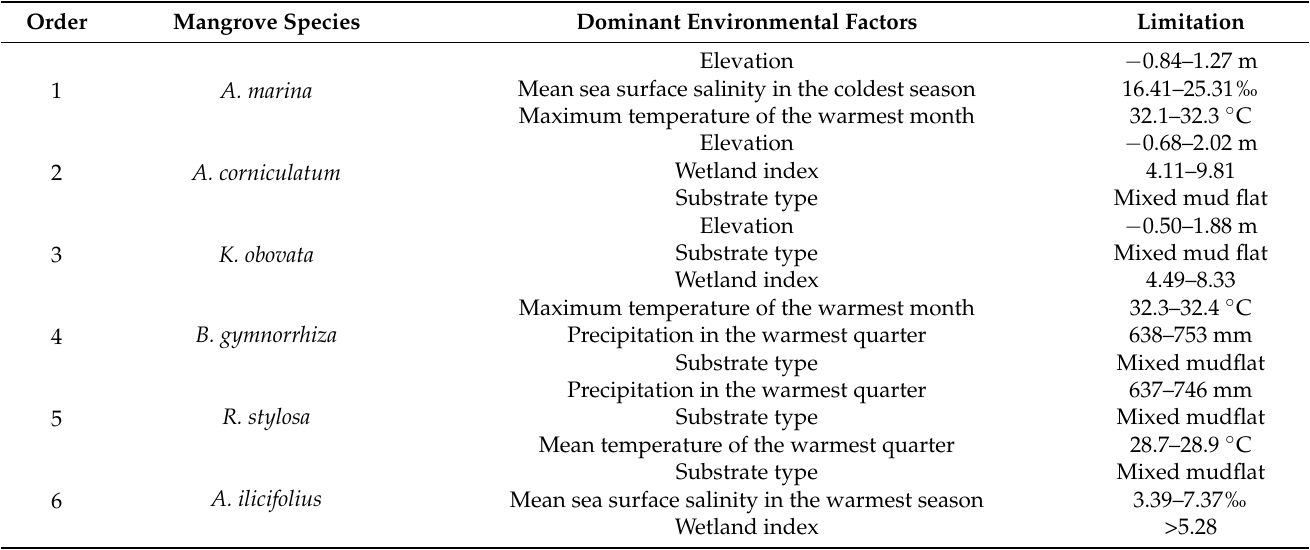
Table 3. Thresholdsofthedominant environmentalfactorsthataffectedthesixmangrovespeciesdistributions.